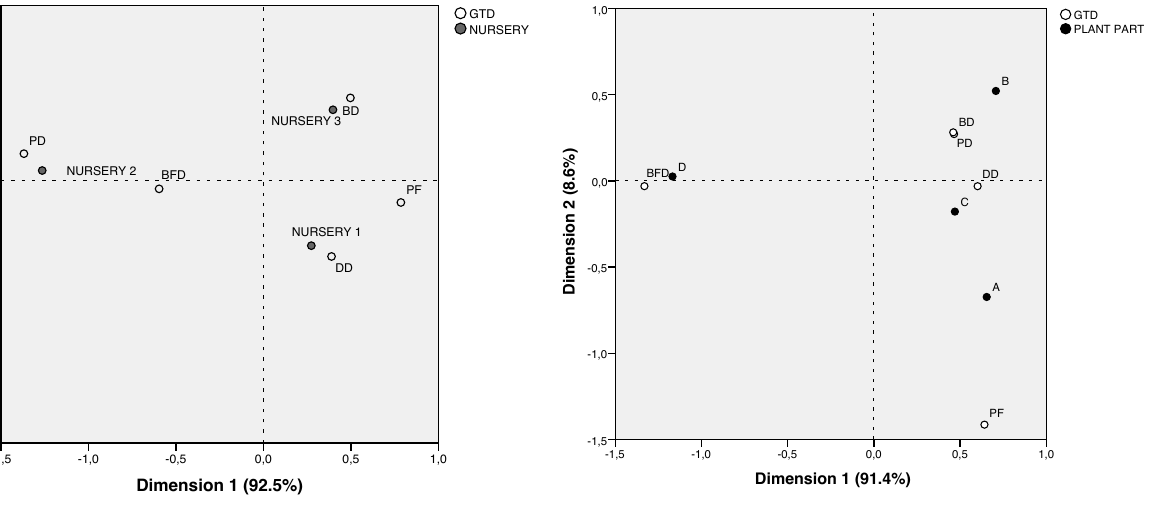
Figure 2. Correspondence analysis biplot between GTDs and the analyzed plant parts (A: scion; B: graft union; C: rootstock; D: roots). BFD = Black foot disease, BD = Bot- ryosphaeria dieback, PD = Petri disease, DD = Diaporthe dieback, and PF = Pestalotioid fungi.